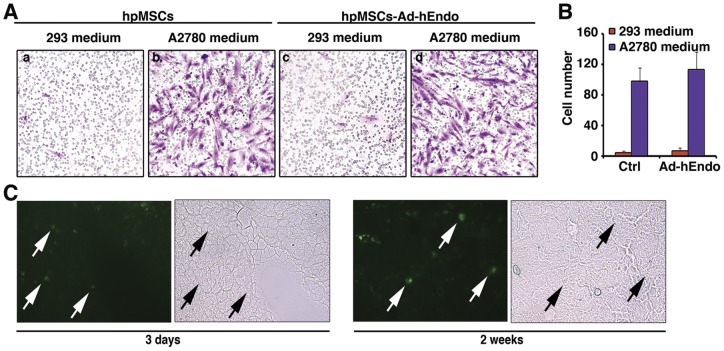
Migratory ability of transduced hpMSCs in vitro and in vivo.A. Migration of hpMSCs/hpMSCs-Ad-Endo cells through an 8-um Millicell membrane. HpMSCs were cultured in 24-well plate onto 8-um pore-sized membranes, and A2780s or 293 cells were cultured in the lower chamber. The cells migrated to the lower side of the membrane were labeled with methyl violet. Original magnification×400. B. Induction of hpMSCs/hpMSCs-Ad-Endo migration stimulated by A2780s or 293 cells. Compared with 293 cells, A2780s cells promoted migration of hpMSCs//hpMSCs-Ad-Endo significantly. Data shown as means ± SD. C. To verify the specific homing property of transducted mesenchymal to tumor site, we transducted hpMSCs with adenovirus carrying GFP and injected i.p. to nude mice with established peritoneal ovarian tumor. After 3 days and 2 weeks of i.p. injection, mice were sacrificed and tumor nodules and organs were collected. Left panel: 3 days after i.p. injection, GFP signal (arrow) were detected at tumor periphery. Right panel: 2 weeks after i.p. injection, positive GFP signal were detected in the tumor parenchymal (arrow) which indicated hpMSCs persist in the xenograft and can integrate into tumor focus. There is no positive GFP signal detected in the organs.